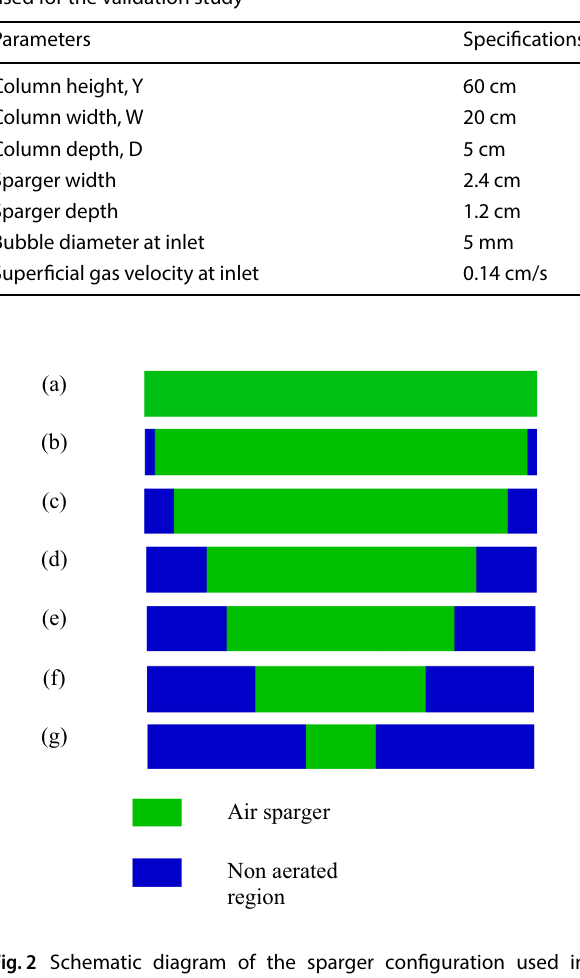
Fig. 2 Schematic diagram of the sparger configuration used in numerical simulations a A1, b A2, c A3, d A4, e A5, f A6 and g A7